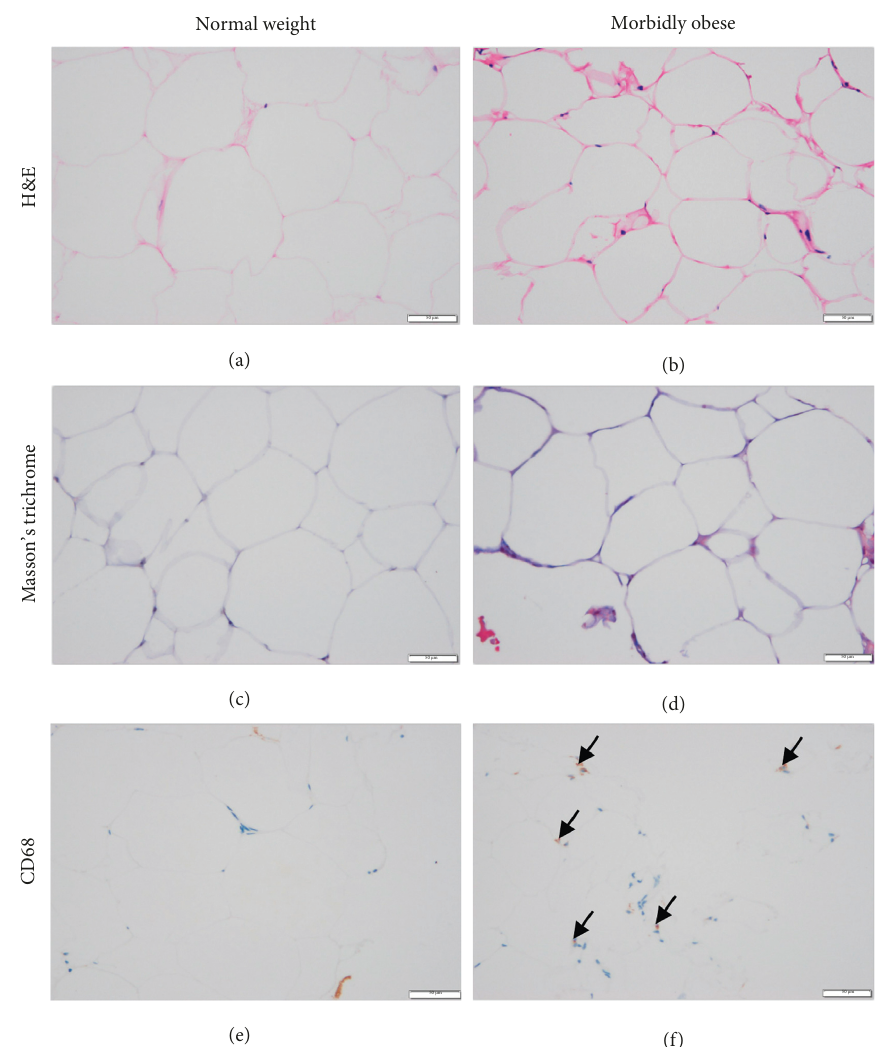
Figure 6: Morphometry and histological analysis of VAT in normal weight and morbidly obese subjects. (a, b) H&E staining showed that there was more inflammatory cellular infiltration in the VATof morbidly obese patients. (c, d) Masson’s trichrome staining demonstrated increased collagen fiber deposition (blue) in VATof morbidly obese patients. (e, f) Representative immunohistochemical staining showed that there were more CD68-positive macrophages in the VAT of morbidly obese subjects. Arrowhead: macrophage. Scale bar: 50 μ